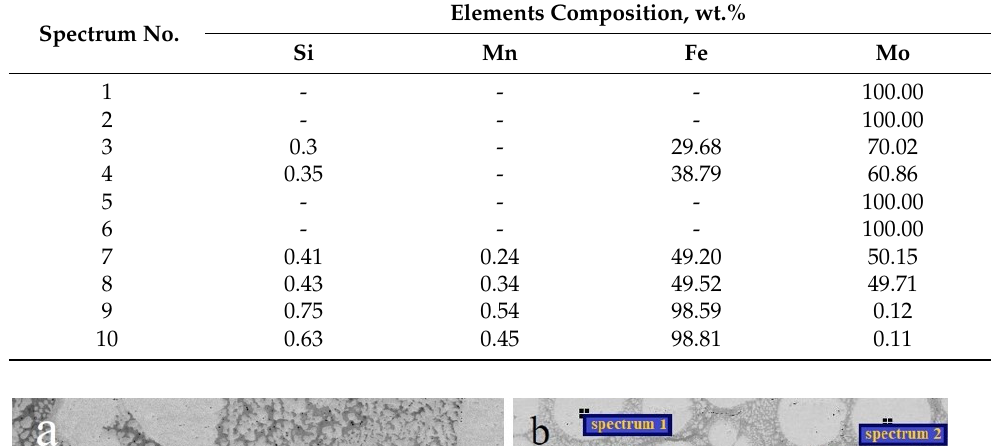
Figure 10. Microstructure of the Mo-steel boundary after LDED (×500): ( a ) PM-M powder with 1—pores and 2—cracks; ( b ) PMS-M99.9 powder.